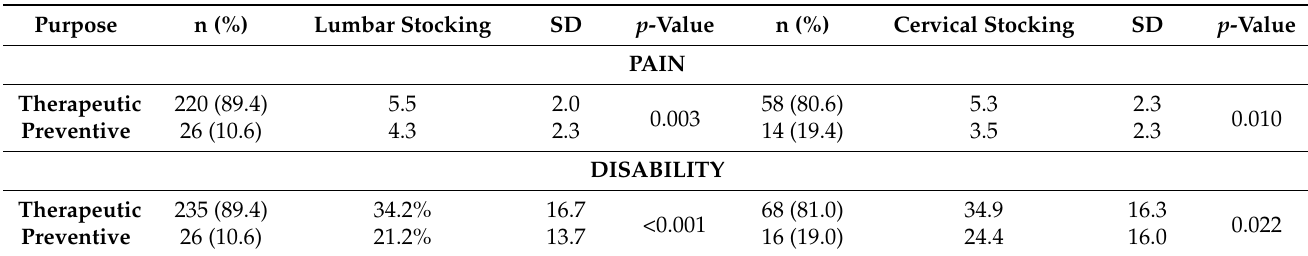
Table 5. First evaluation of the BS: pain and disability according to the purpose of the BS for workers in the construction sector.